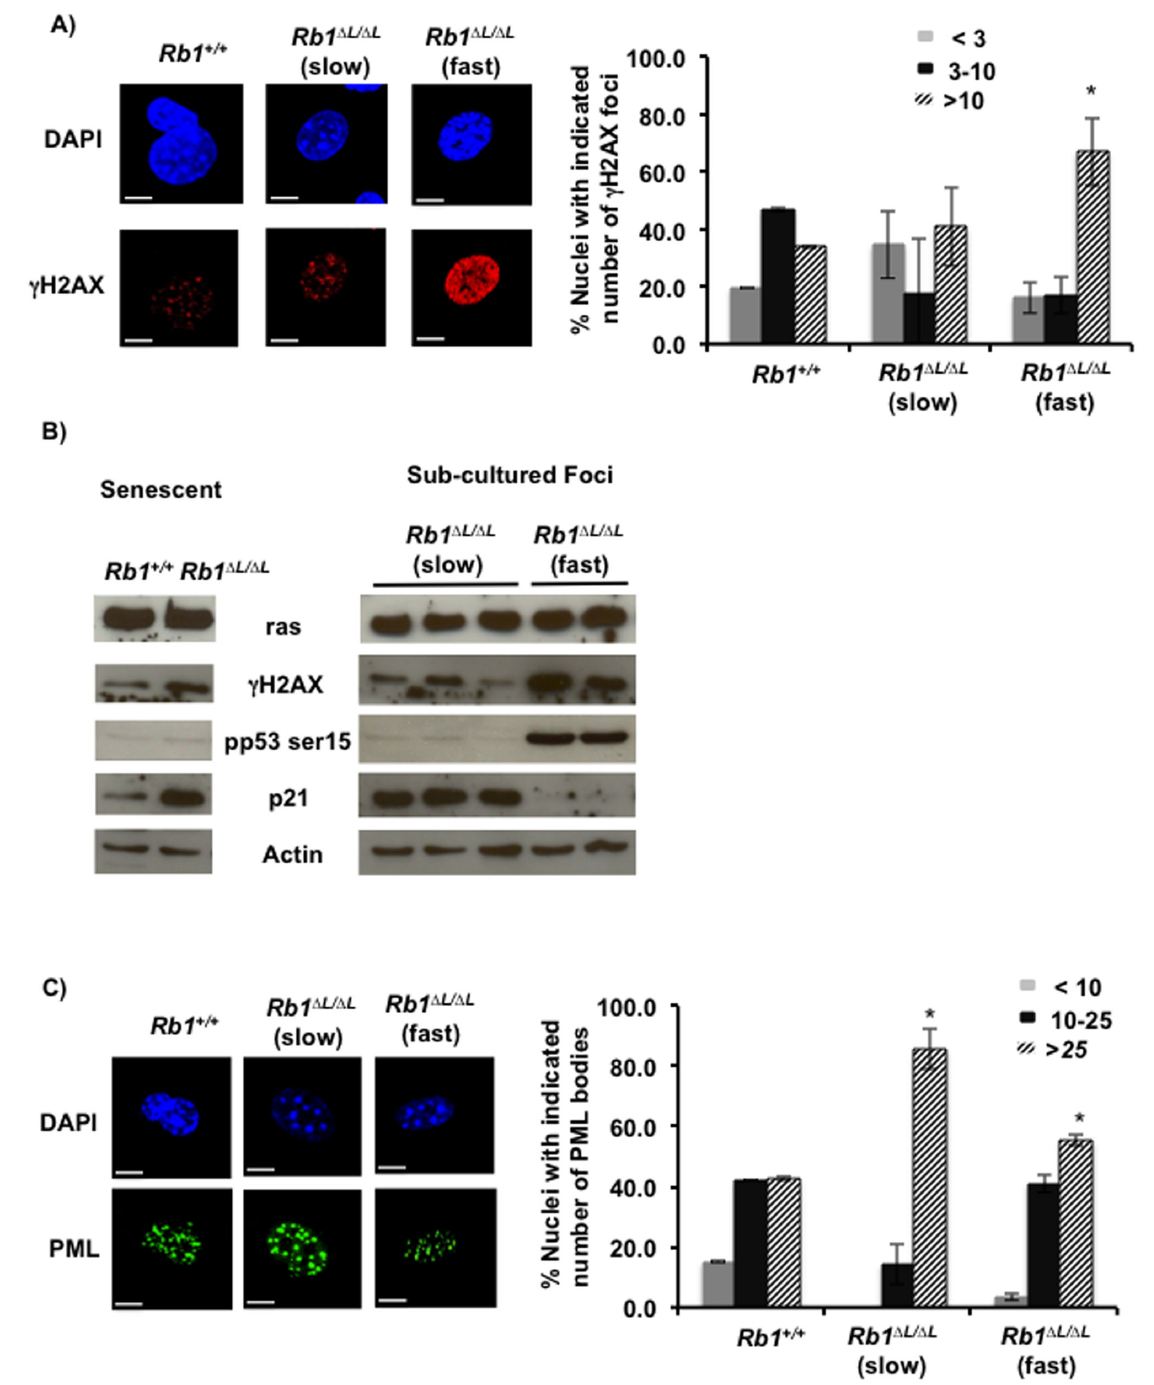
Figure 2. Increased DNA damage in Rb1 ∆L/∆L cells sub-cultured from foci. Rb1 +/+ and Rb1 ∆L/∆L clones were sub-cultured from foci and stained with antibodies against γH2AX and PML. ( A ) Immuno-fluorescent staining of Rb1 +/+ and Rb1 ∆L/∆L clones with a γH2AX specific antibody to determine the extent of DNA damage. Quantitation is shown in the graph on the right. Asterisk indicates significant difference from wild type controls (t-test, p<0.05). Scale bars are 10µM. ( B ) Western blots for DNA damage response proteins in senescent Rb1 +/+ and Rb1 ∆L/∆L MEFs (left) and slow and fast growing Rb1 ∆L/∆L sub-cultured foci are shown. ( C ) Anti-PML antibody staining of Rb1 +/+ and Rb1 ∆L/∆L cells sub-cultured from foci. Quantitation of PML nuclear bodies is shown on the graph to the right. Asterisk indicates significant difference from wild type controls (t-test, p<0.05). Scale bars are 10µM. doi: 10.1371/journal.pone.0072236.g002 PLOS ONE |